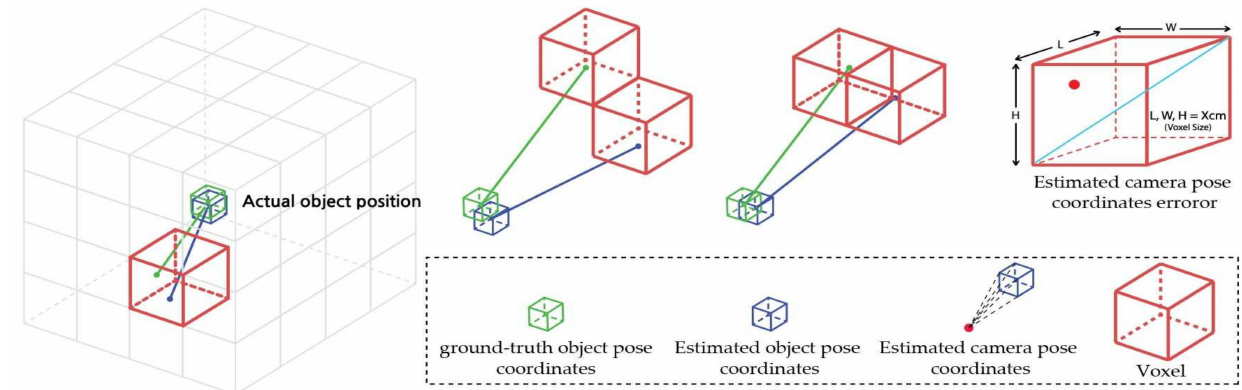
Figure 3. Visual positioning system (VPS) error and